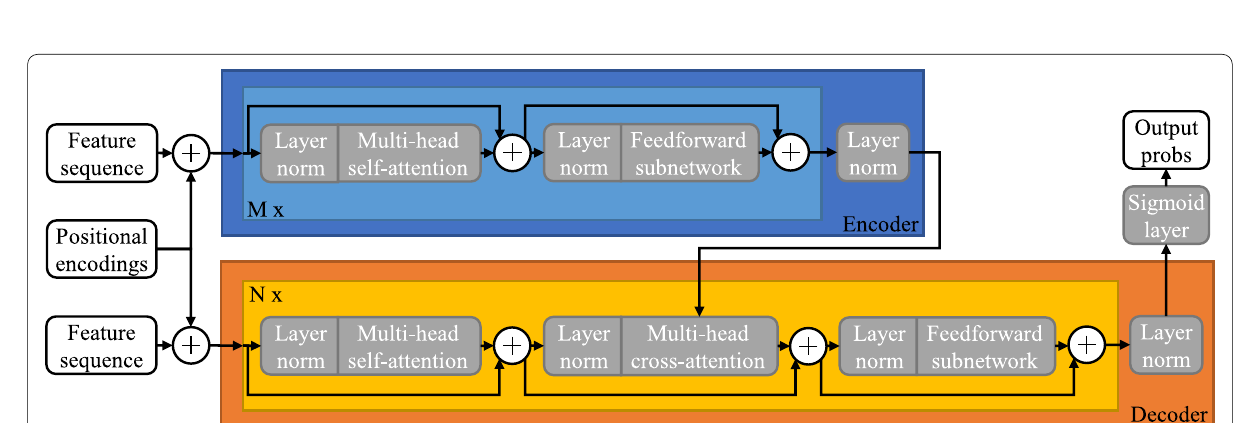
Fig. 1 Diagram of transformer model for sound